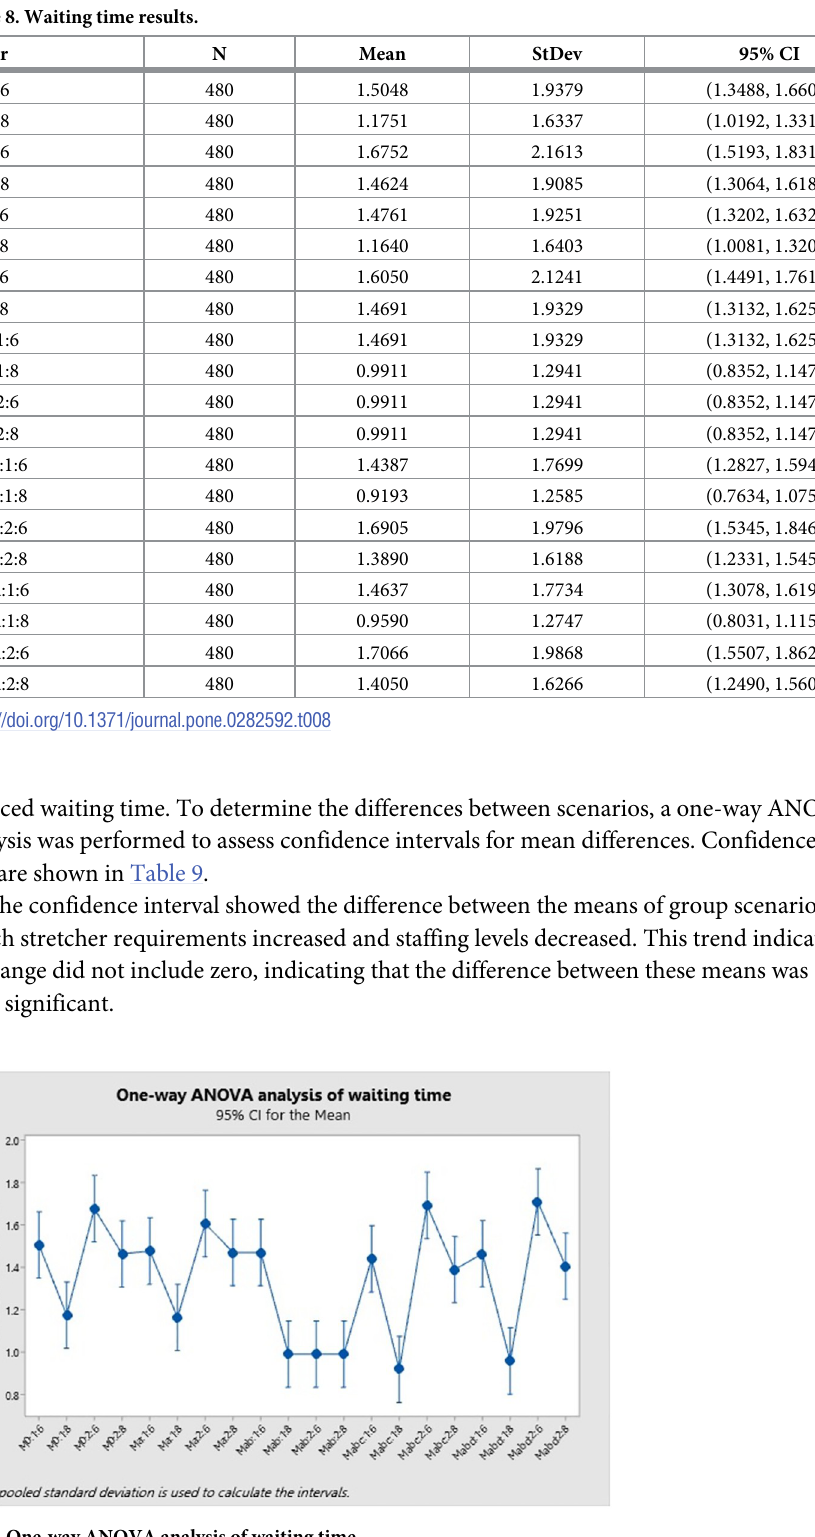
Fig 4. One-way ANOVA analysis of waiting